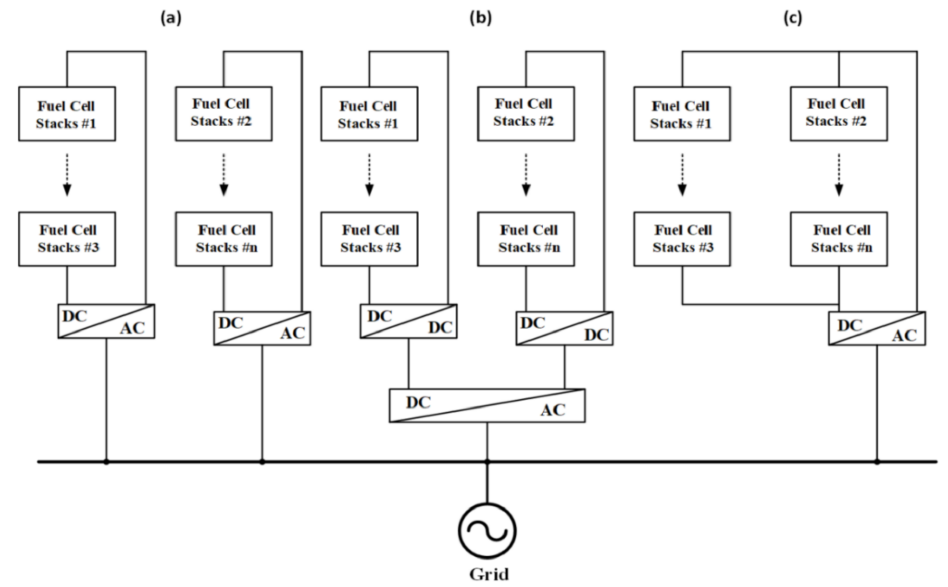
Figure 1. ( a ) String configuration; ( b ) multi-string configuration, and ( c ) centralised configuration